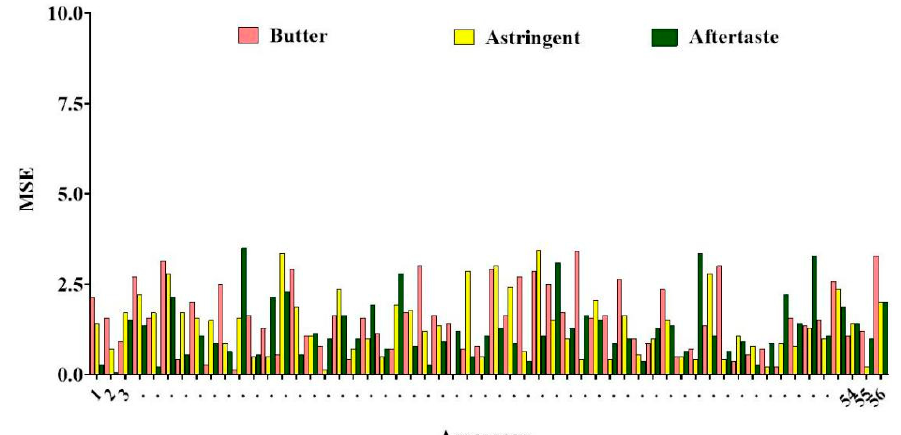
Figure 1. Analysis of assessment capacity of sensory evaluators enrolled in this study of fourteen Chinese milk powder samples. Mean squared error (MSE) values indicate within-group variance of sensory evaluators. 1, 2, 3... 56 represent 56 sensory evaluators.